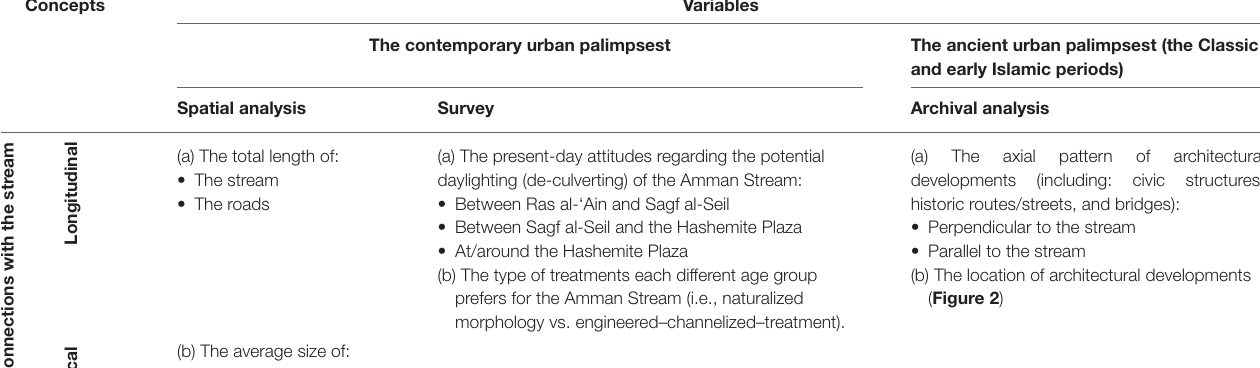
TABLE 1 | The variables we investigated in our spatial analysis using ArcGIS and in the online survey to assess the impacts of the loss of the Amman Stream on its connections to urban form and on its regulatory and socio-cultural ecosystem services.